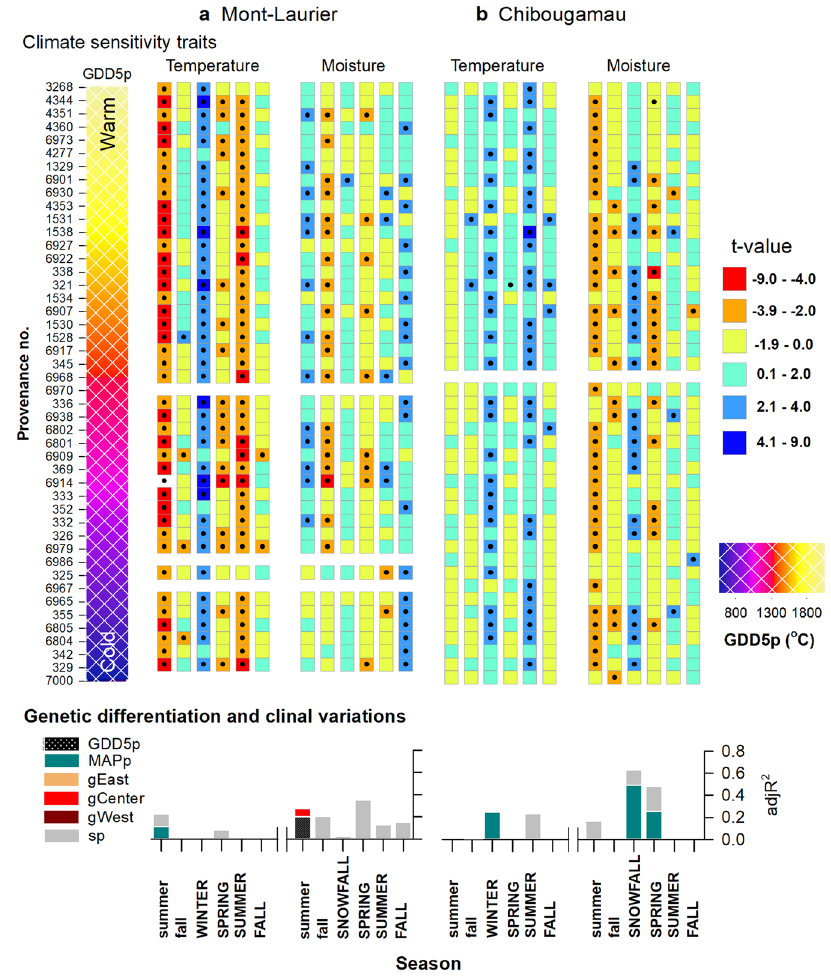
Fig. 3 Productivity – climate associations. Season – provenance diagrams: climatic sensitivity traits (CStraits), represented by t -value scores of the generalized additive mixed models (GAMM) linking annual NPP and annual seasonal temperature, soil moisture and snowfall fl uctuations, by population and common garden site a Mont-Laurier ( n = 42 independent populations) and b Chibougamau ( n = 45 independent populations). A positive in fl uence of a climate variable on NPP is denoted in blue; a negative in fl uence is denoted in red. The period of analysis was 1976 – 2016. Studied populations (rows) are ordered by increasing mean annual growing degree days above 5 °C at provenance (GDD5p; color scale at left from warm to cold; legend at far right) origin. Seasons in capital letters represent the current year of ring formation; seasons in lower case represent climate variables during the year preceding ring formation. Signi fi cant t -value scores at the 5% level (two sided) are represented by dots. Vertical-bar plots: Tests for genetic differentiation and clinal variations in t -value scores using generalized additive models (GAM). A high adj R 2 value denotes a high goodness-of- fi t between NPP and the explanatory variables GDD5p, mean annual precipitation (MAPp), admixture proportions along Western, Central, and Eastern genetic clusters (gWest, gCenter, gEast), and spatial factors (sp) represented by the distance-based Moran ’ s eigenvector maps. All shown variables are signi fi cant at the two-sided 5% (Fig. 2, vertical-bar plots; GAM R ² up to 0.30). This is indicative of a high degree of variation among populations, both within and between glacial lineages in association with the climate of the provenance. According to observations and GAM predic- tions, the best-performing populations were local ones at the Mont-Laurier site. For instance, the GDD5p of populations pre- dicted as having had the highest NPP in 1984 were approximated to be 1585 to 1735 °C, which is close to the GDD5 at the Mont- Laurier common garden site (1635 °C) (Fig. 5a, left column).